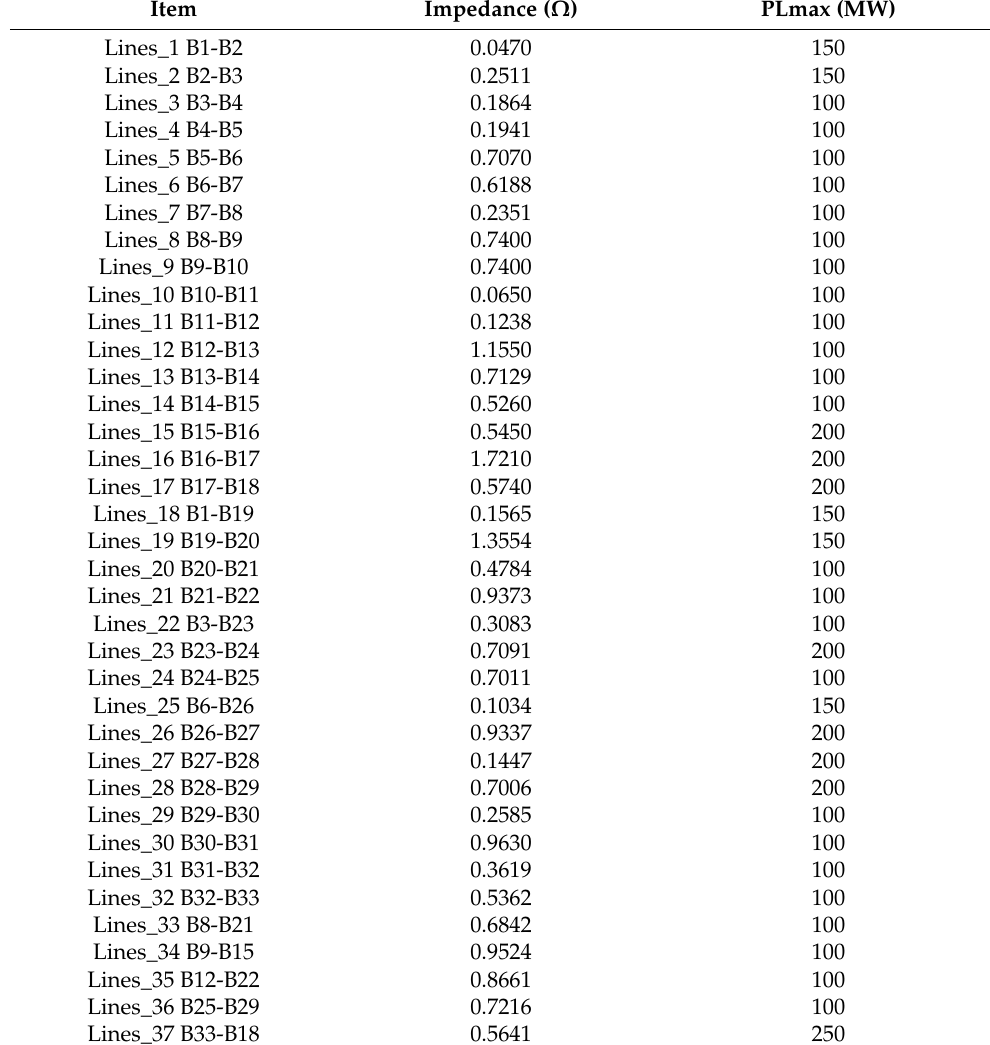
Table A6. Parameters of the 33-bus system.